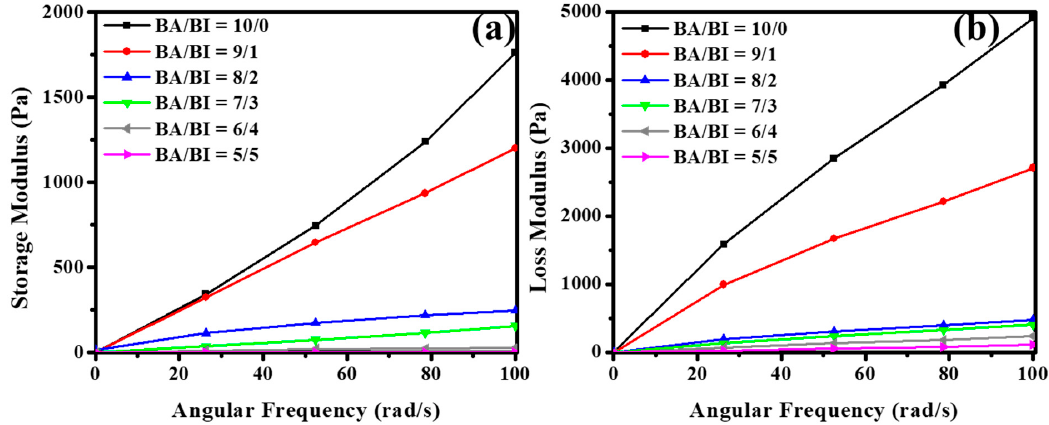
Figure 8. ( a ) Storage and ( b ) loss modulus of PBABI copolyesters with different BA/BI ratios as a function of angular frequency with 0.1–100 rad s − 1 at 80 °C.